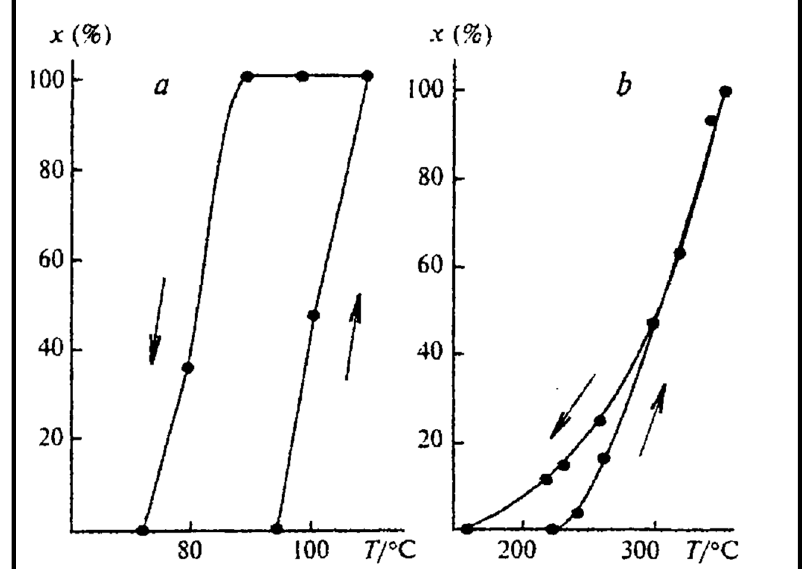
Figure 4. Hysteresis behavior during CO oxidation over unsupported copper oxide (CuO) ( a ) and over Pt foil ( b ) (the arrows mark the increase and the decrease in temperature) [63].